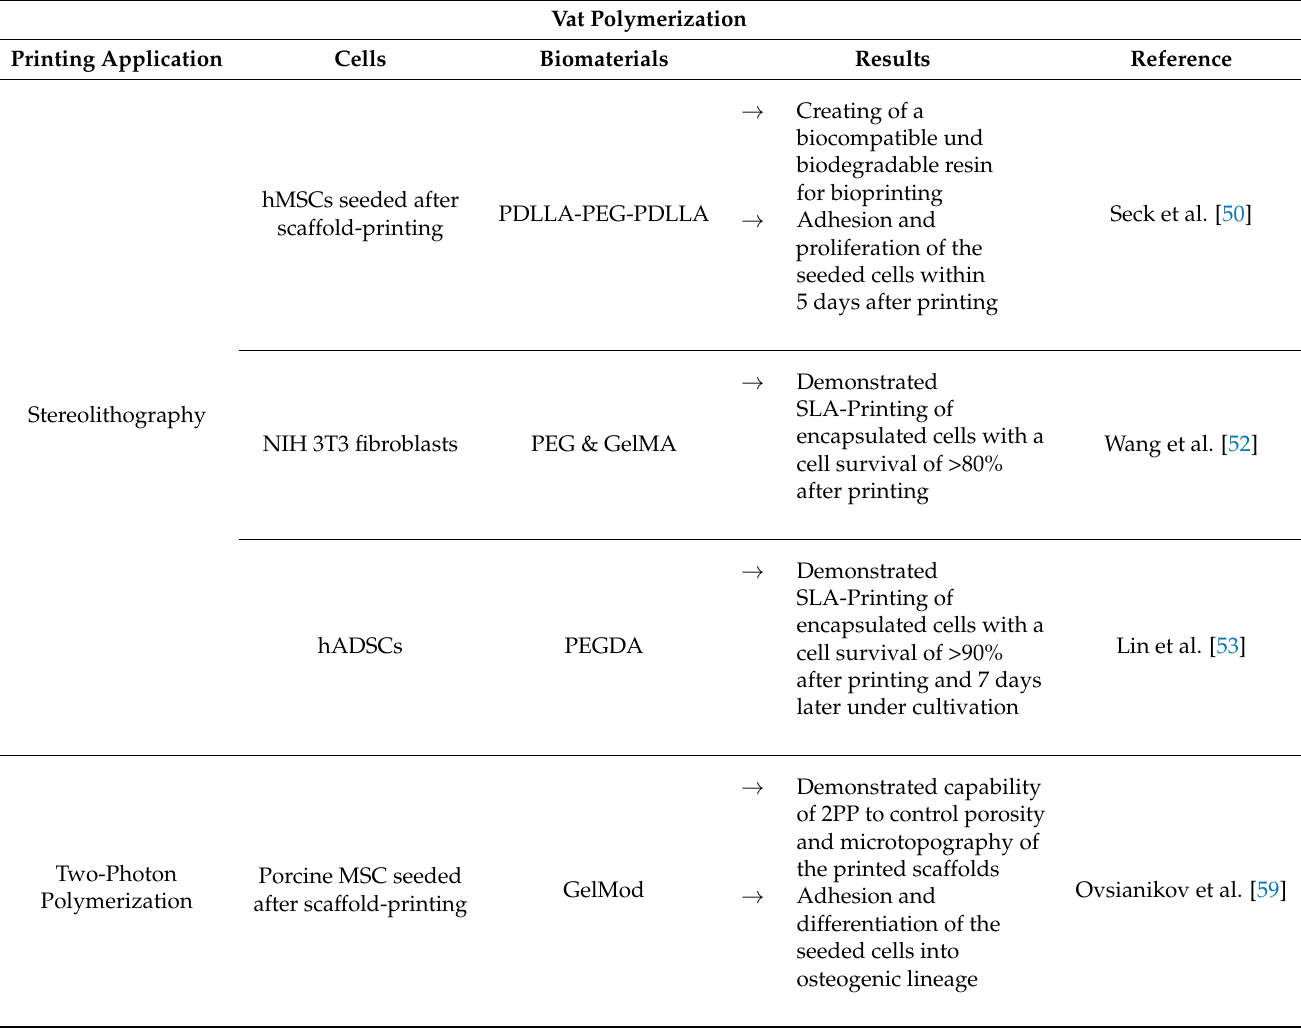
Table 1. Vat polymerization-based printing technologies in tissue engineering: Overview of recent study results. hMSC: human mesenchymal stem cell; PDLLA: poly (D, L-lactic acid); PEG: polyethylene glycol; GelMA: gelatin-methacrylamide; hADSC: human adipose-derived stem cell; MSC: mesenchymal stem cell; PEGDA: polyethylene glycol diacrylate; MSC: mesenchymal stem cells; GelMod: methacrylamide-modified gelatin; CHO: Chinese hamster ovary; SU-8: SU-8 photoresist; SLA: stereolithography; 2PP: 2-photon